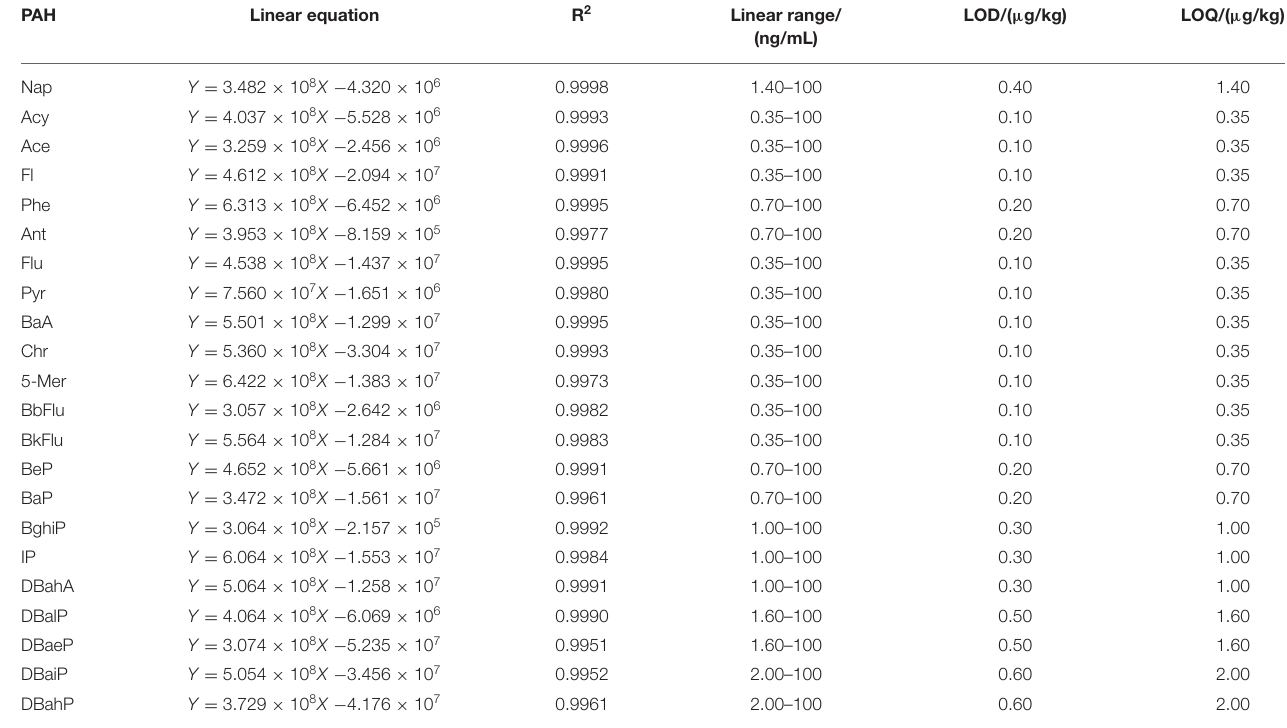
TABLE 2 | Linear equations, correlation coefficients, linear ranges, LODs and LOQs of the 22 PAHs. PAH Linear equation R 2 Linear range/